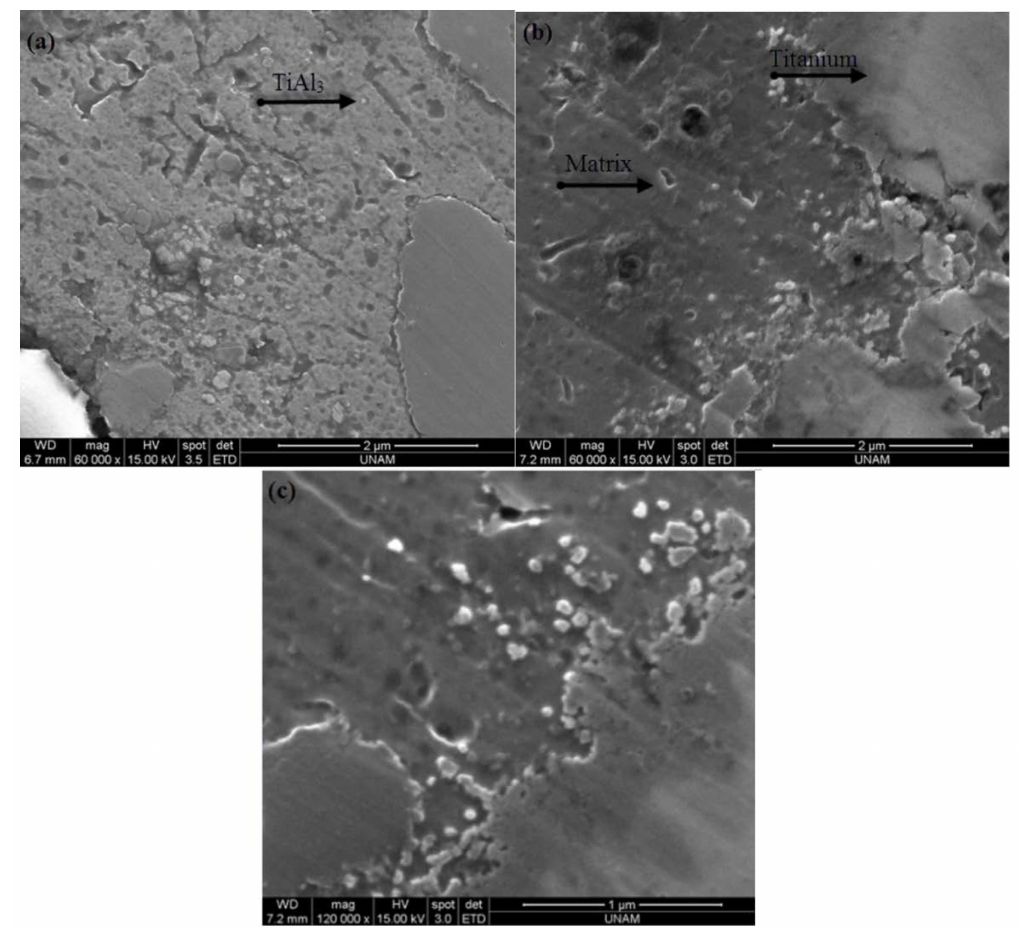
Figure 1. SEM images of Al-Ti alloys 4% Ti ( a ); 6% Ti ( b ); and 8% Ti ( c ) sintered at 530 ˝ C for 1